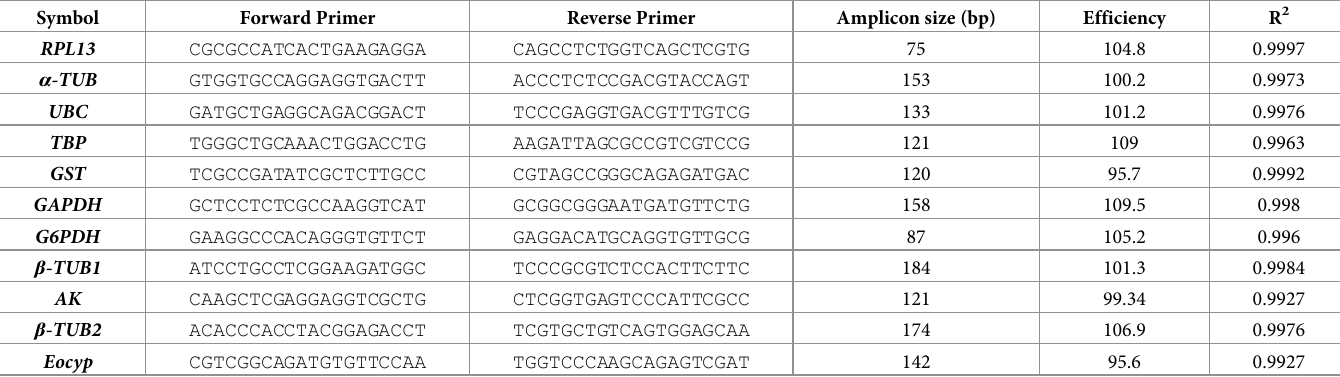
Table 3. Primers of Candidate Reference Genes in E . onukii for